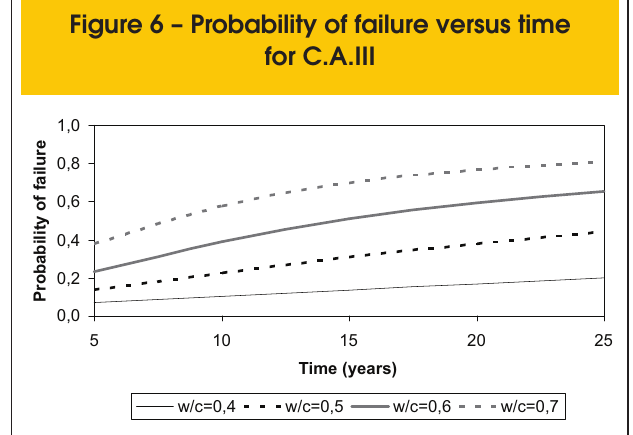
Figure 6 – Probability of failure versus time for